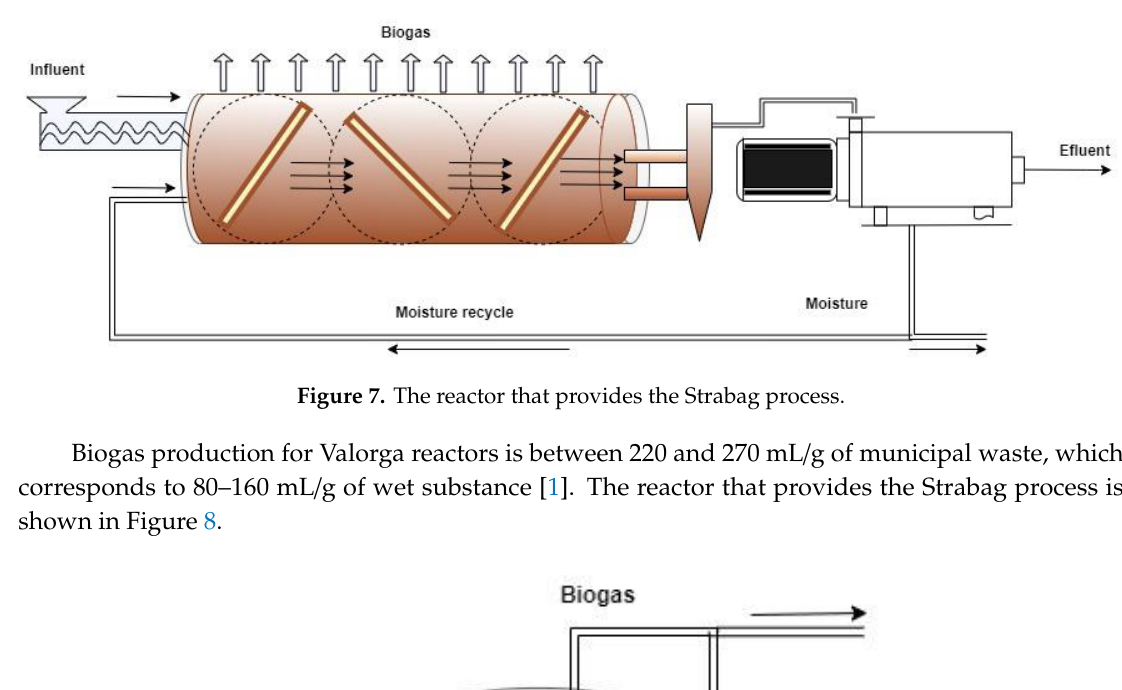
Figure 6. The reactor that provides the Kompogas process.